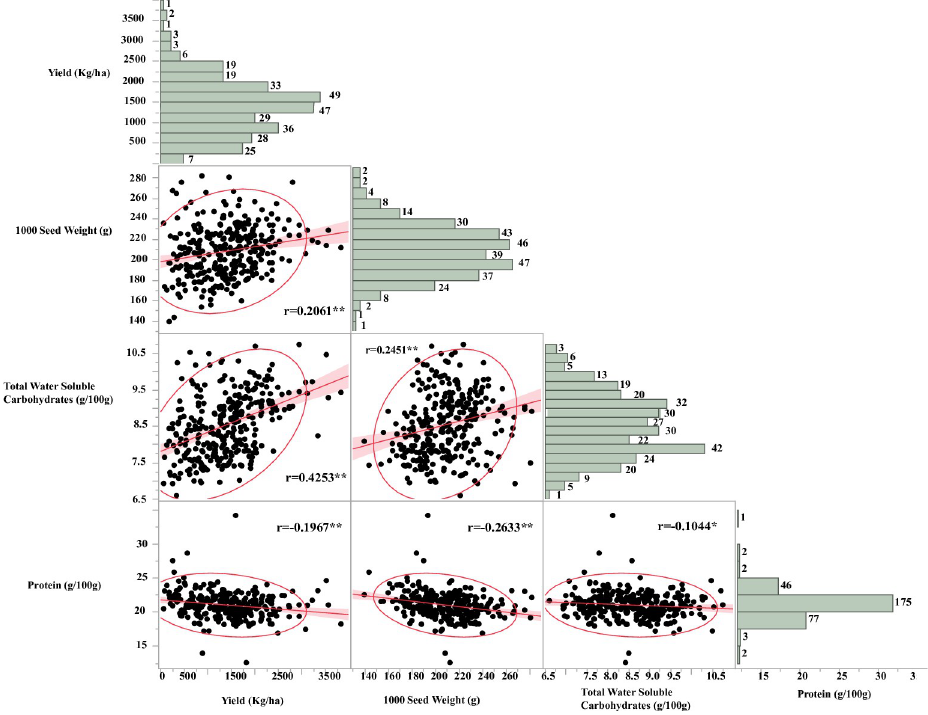
Fig 3. Correlations and distribution of grain yield, 1000 seed weight, total water-soluble carbohydrates, and protein concentration among the genotypes grown under organic field conditions.